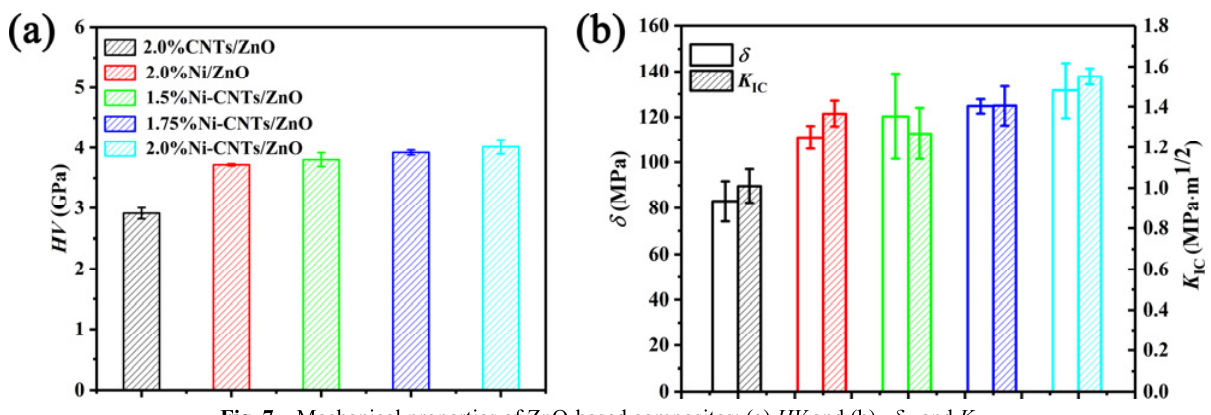
Fig. 7 Mechanical properties of ZnO-based composites: (a) HV and (b)  and K IC